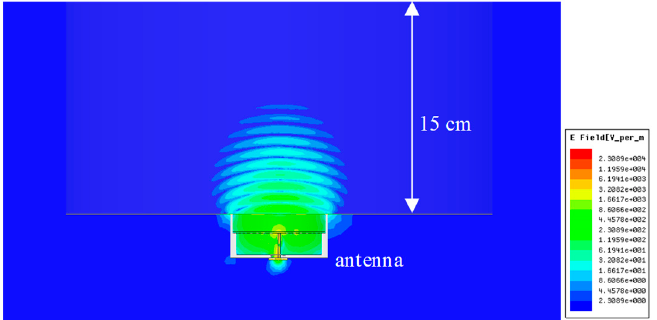
Figure 6. Simulation of electric field distribution inside the human body.